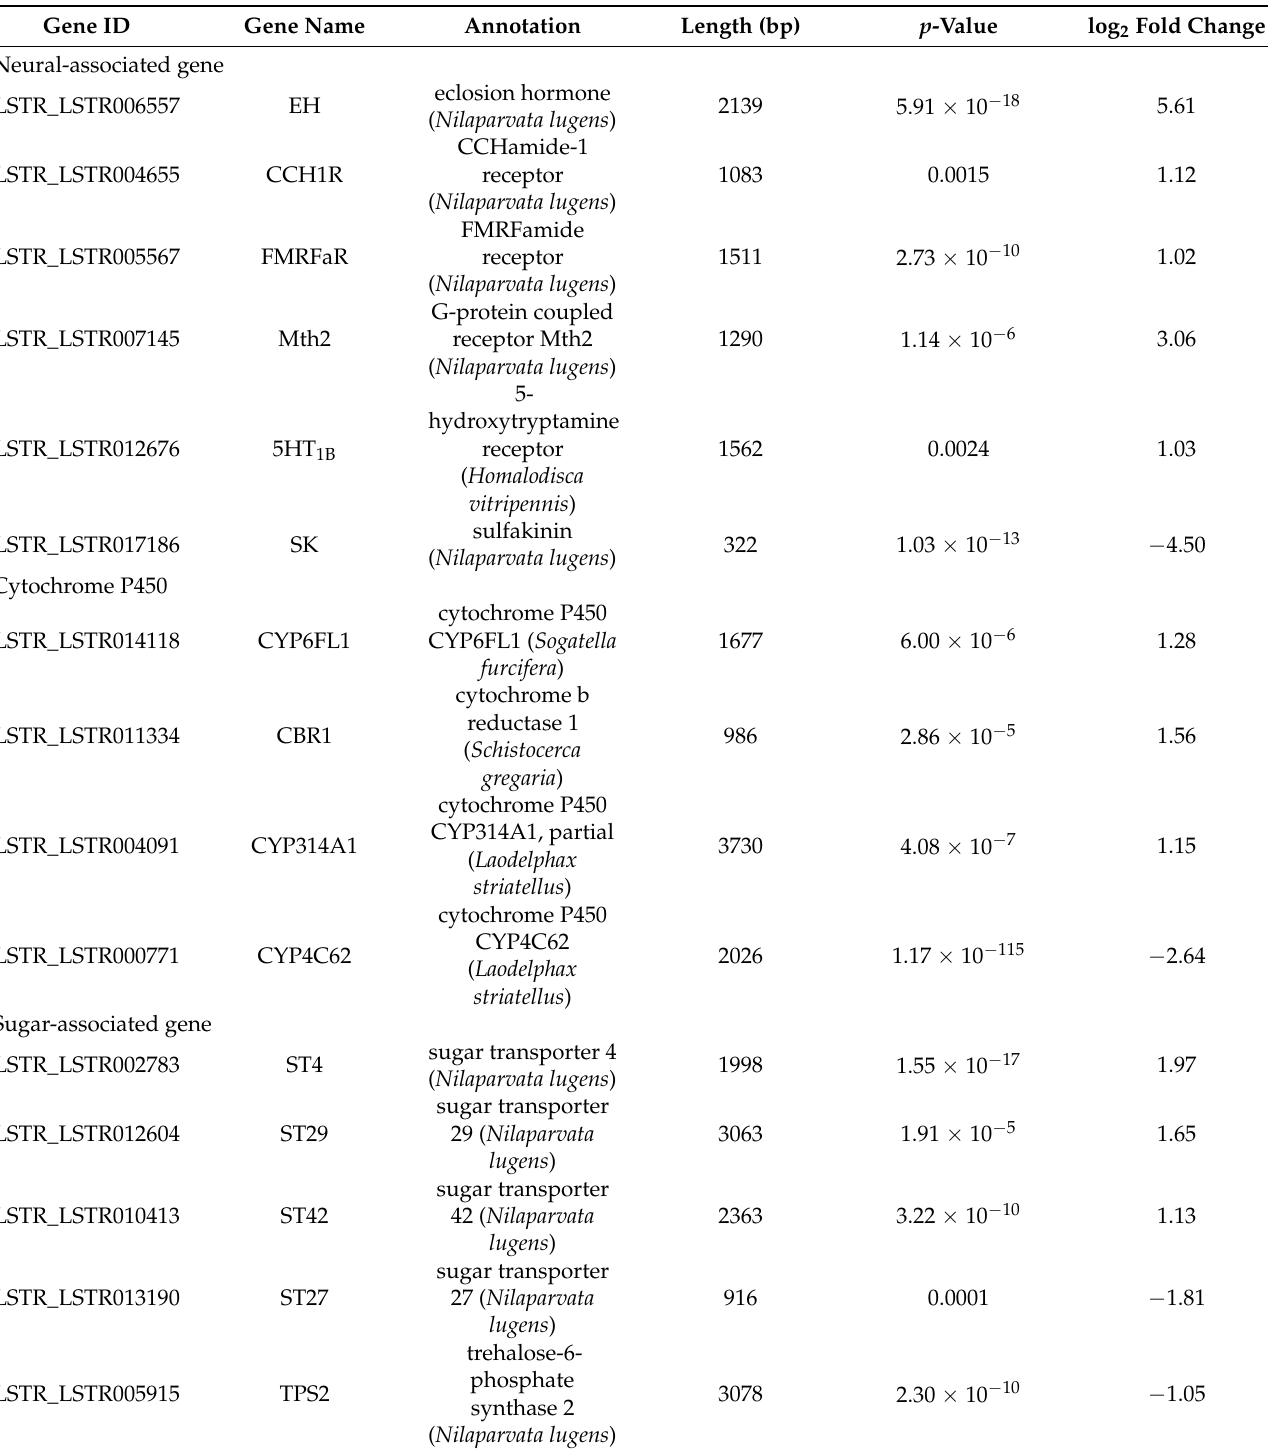
Table 3. Identification of DEGs possibly associated with virus transmission between viruliferous and non-viruliferous SBPH